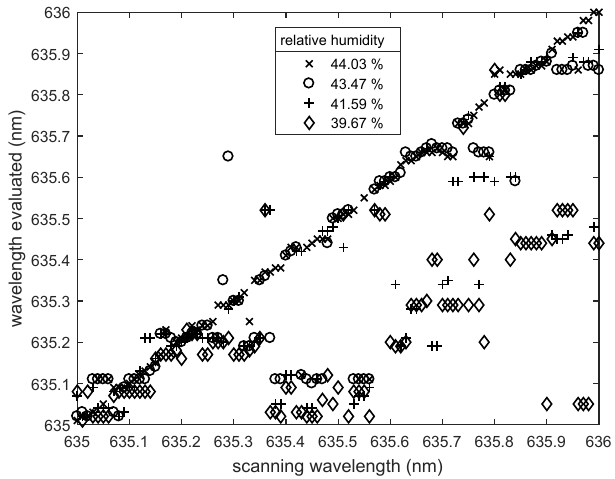
Figure 7. Determined wavelength compared to the laser scanning wavelength for a fixed sensor array at different relative humidity levels. The initial relative humidity was 44.46%, and the array consisted of twenty fixed spheres with diameter of